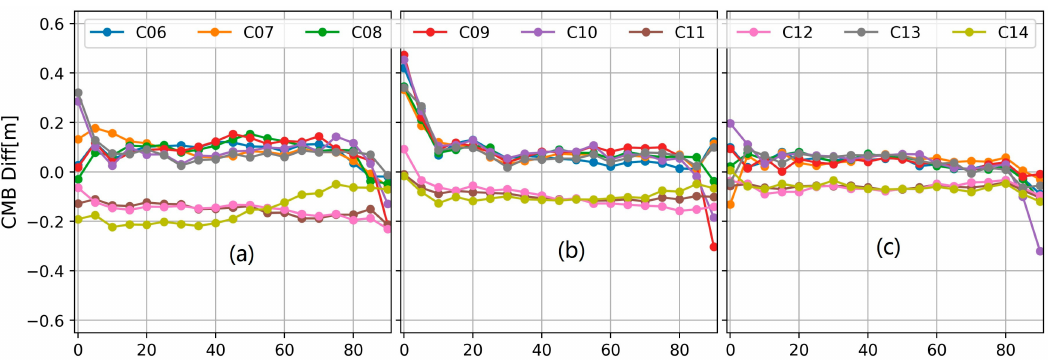
Figure 4. The differences of the CMB values between our proposed model and the traditional model. ( a ) the differences at the B1 frequency; ( b ) the differences at the B2 frequency; ( c ) the differences at the B3 frequency.